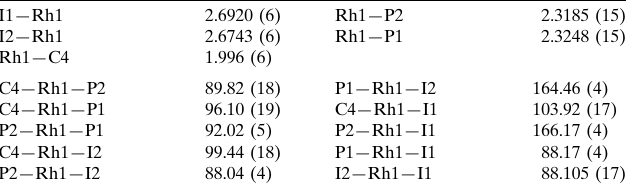
Selected geometric parameters (A˚ , (cid:2)